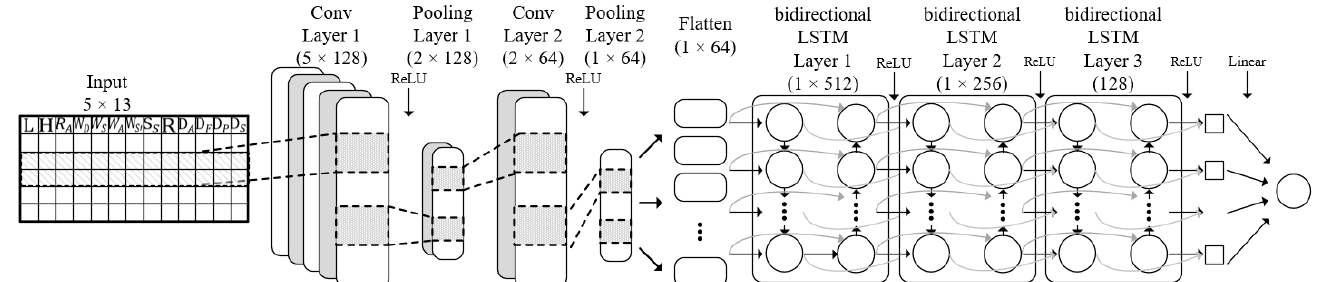
Figure 4. Construction of CNN–bidirectional LSTM (direct).